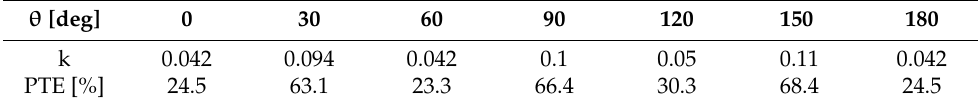
Table 4. Coupling coefficient and power transfer efficiency (PTE) of WTT and WPT system.